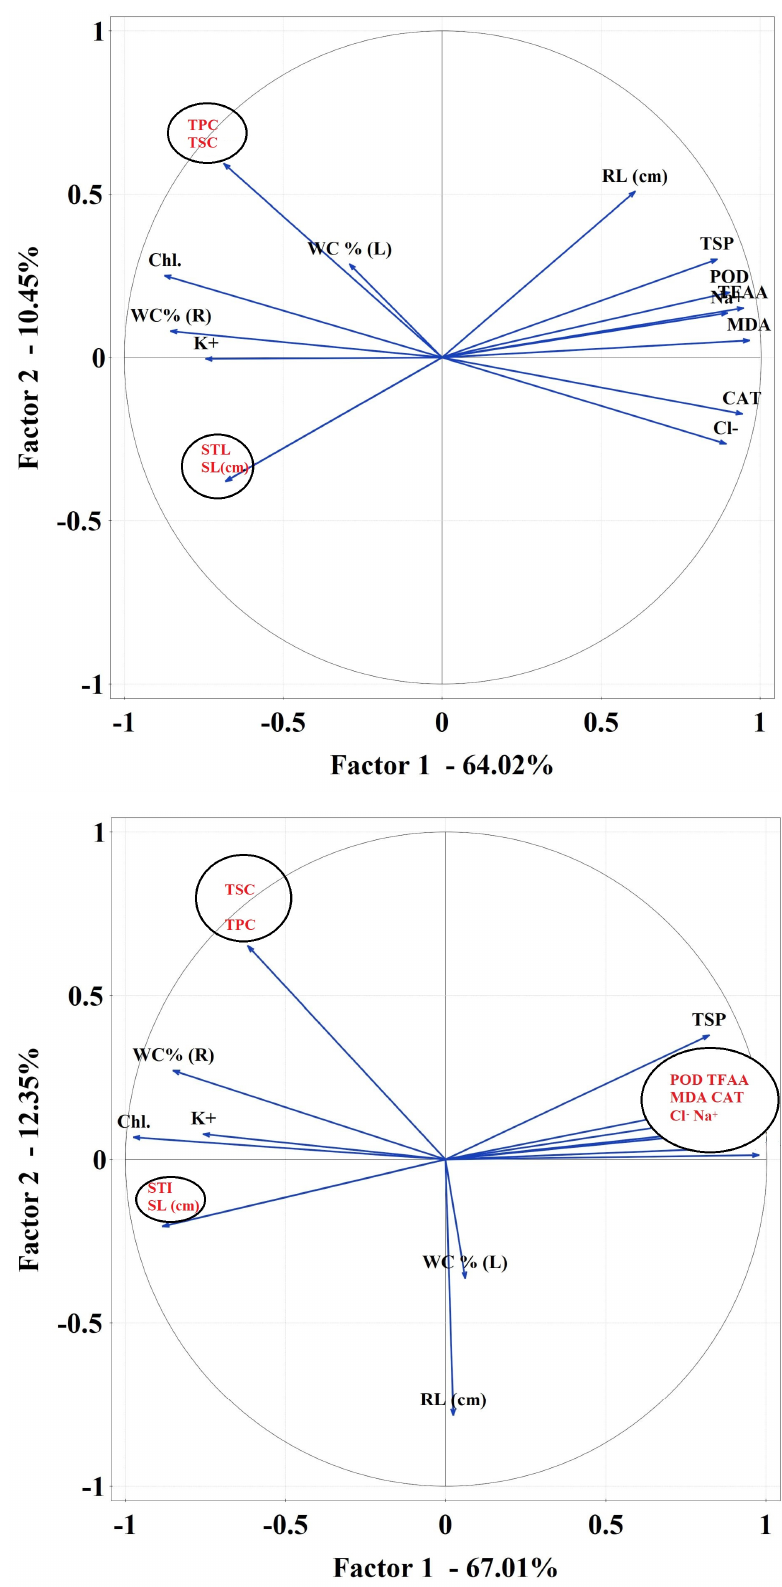
Figure 7c Figure 7. Principal component analysis (PCA) using plot showing all biochemical parameters separately for the first variant of an experiment—salt stress without sugar beet molasses application ( a ), for the second variant of the experiment—salt stress with soil sugar beet molasses application ( b ) and third variant of the experiment—salt stress with foliar sugar beet molasses application ( c